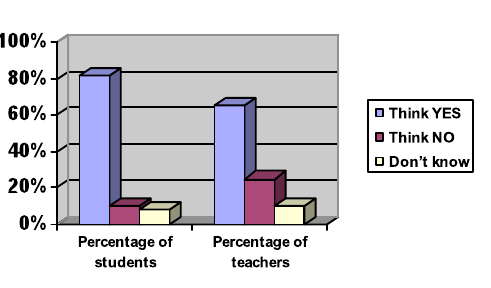
Fig.5. Histogram of the error’s detection rates Fig. 6. Histogram of the Second Test